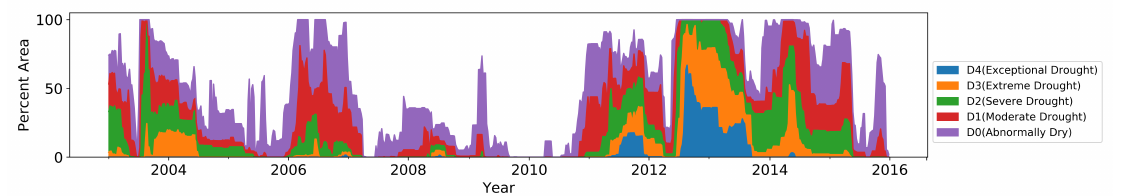
Figure 5. Time series for drought monitor of